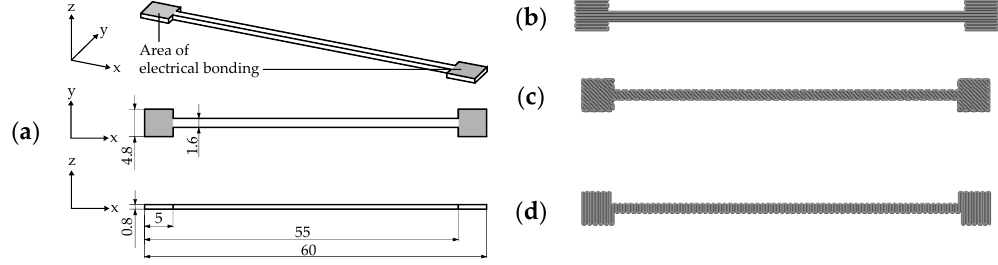
Figure 1. Used test specimens for the determination of influencing factors on resistivity: ( a ) with dimensions and isometric view; and the examined raster angle orientations: ( b ) 0°; ( c ) ±45°; and ( d ) 90°.